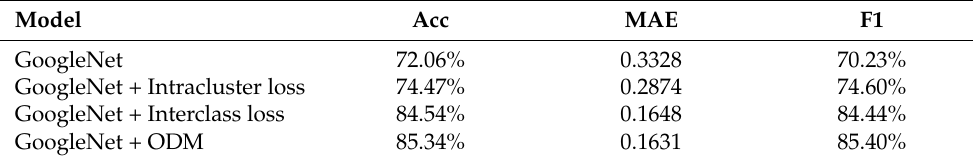
Table 1. Ablation experiment